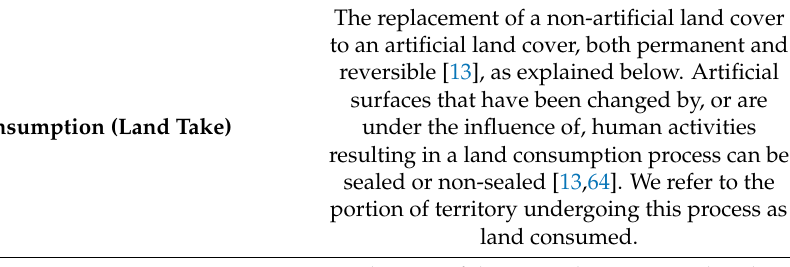
Table A1. Relevant definitions related to land cover, land use and land